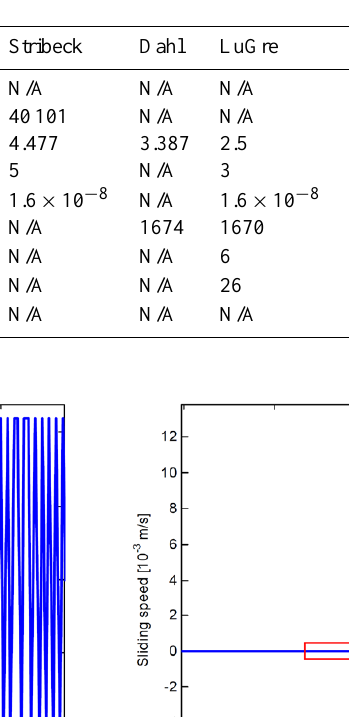
Table 2. Parameters determined for each friction model.